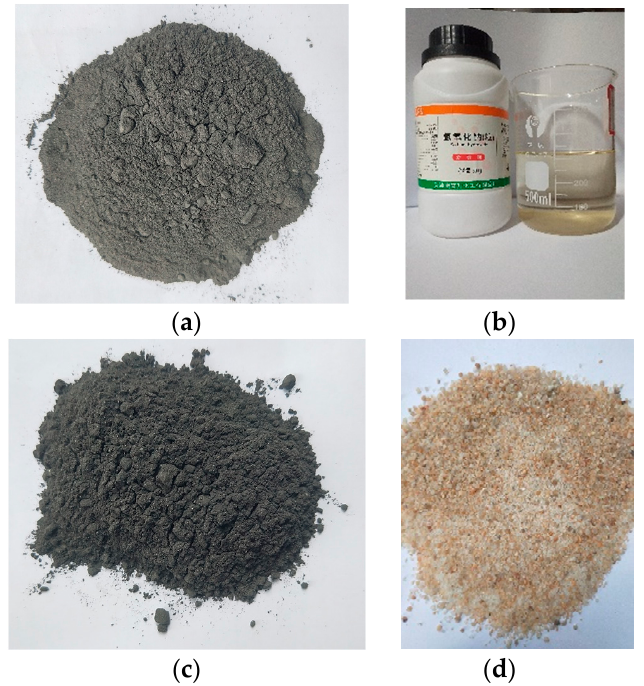
Figure 1. Raw materials for preparing composites: ( a ) fly ash, ( b ) NaOH solution, ( c ) carbide slag, and ( d ) standard